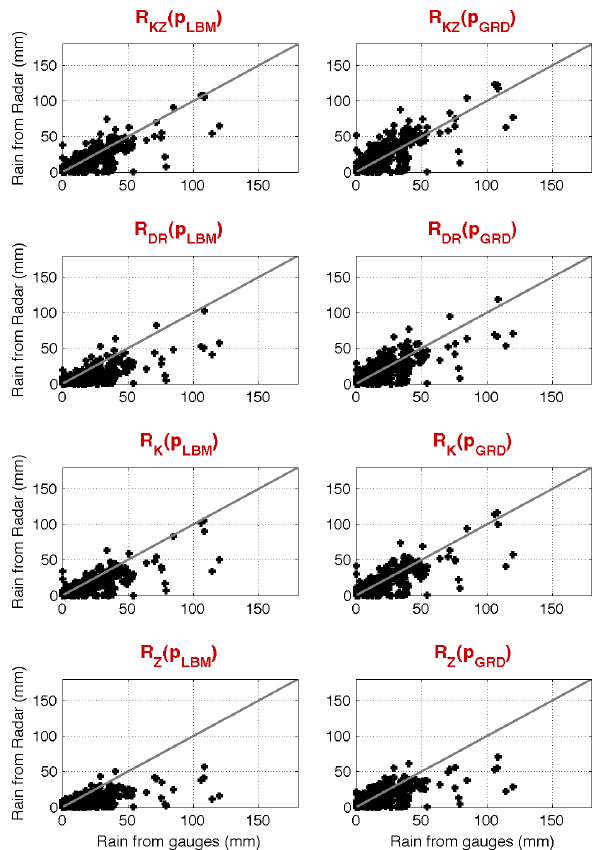
Figure 8. Scatterplots of total rain accumulation over the three case studies on 12 October 2012, 15 October 2015 and 14 October 2015 of rain gauges and radar estimates as specified in each panel’s title. Left column: implementation of Equations (1)–(4) in the main text. Right panels: the same as in the left panel after implementing Equation (7) in the main text.